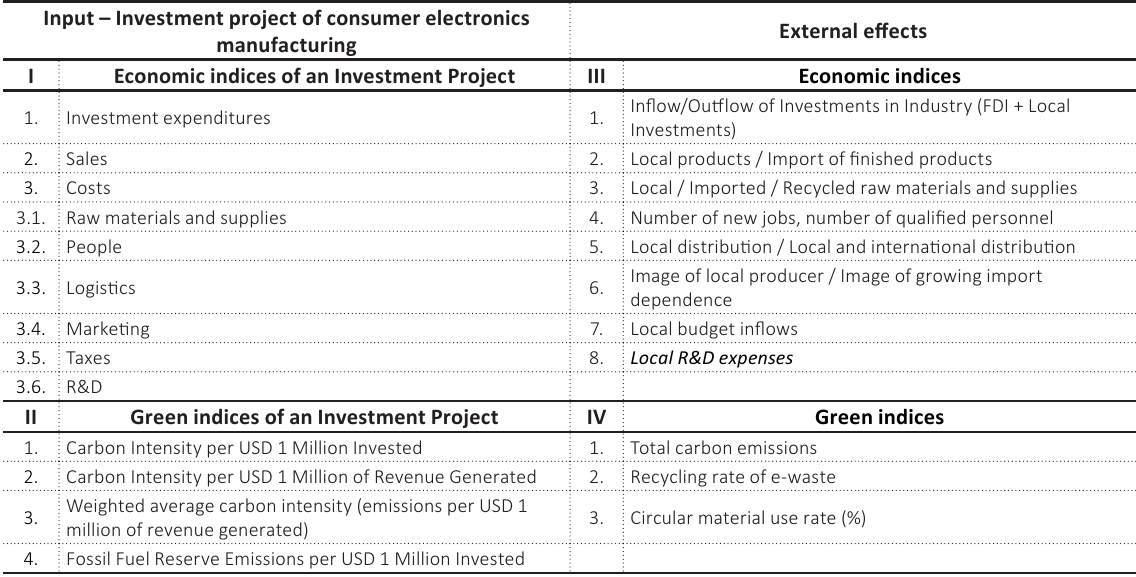
Table 1. Matrix of economic and green impact effects